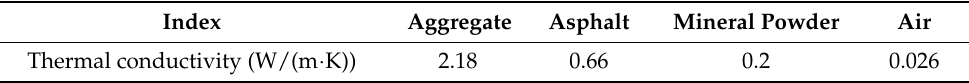
Table 9. Thermal conductivities of the components.